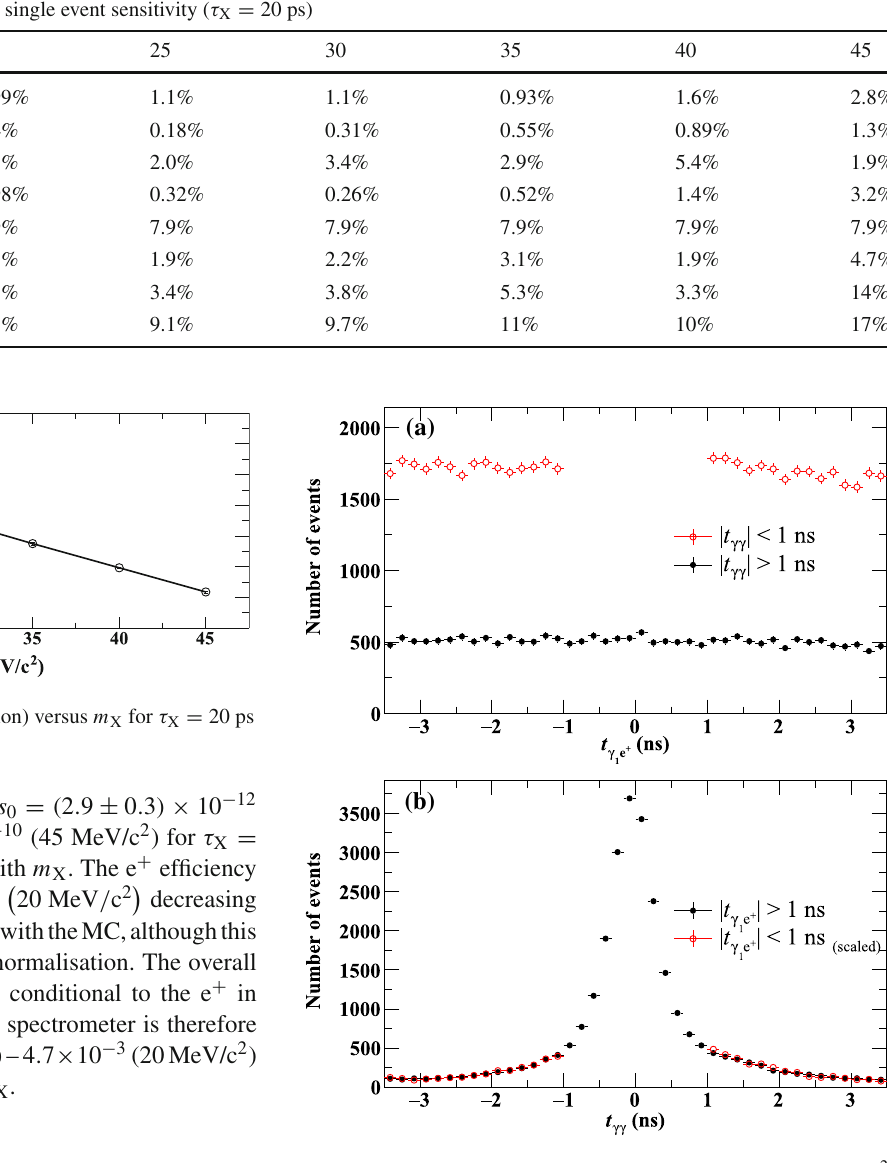
Fig. 16 Time distributions in the sideband regions for (20 MeV/c 2 , 20 ps). (a) t γ distributions for | t γγ | < 1 ns (red open circles) and 1 e + for 1 < | t γγ | < 3 . 5 ns (black closed circles). (b) t γγ distributions for | t γ | < 1 ns (red open circles) and for 1 < | t γ | < 3 . 5 ns scaled 1 e + 1 e + by the ratio of the time ranges (black closed circles). A loose cut is | < 1 MeV ∧ E < 115 MeV ∧ | P | < applied: | E e + − E m X sum sum e + 30 MeV / c ∧ d u v < 90 cm ∧ χ 2 vtx <